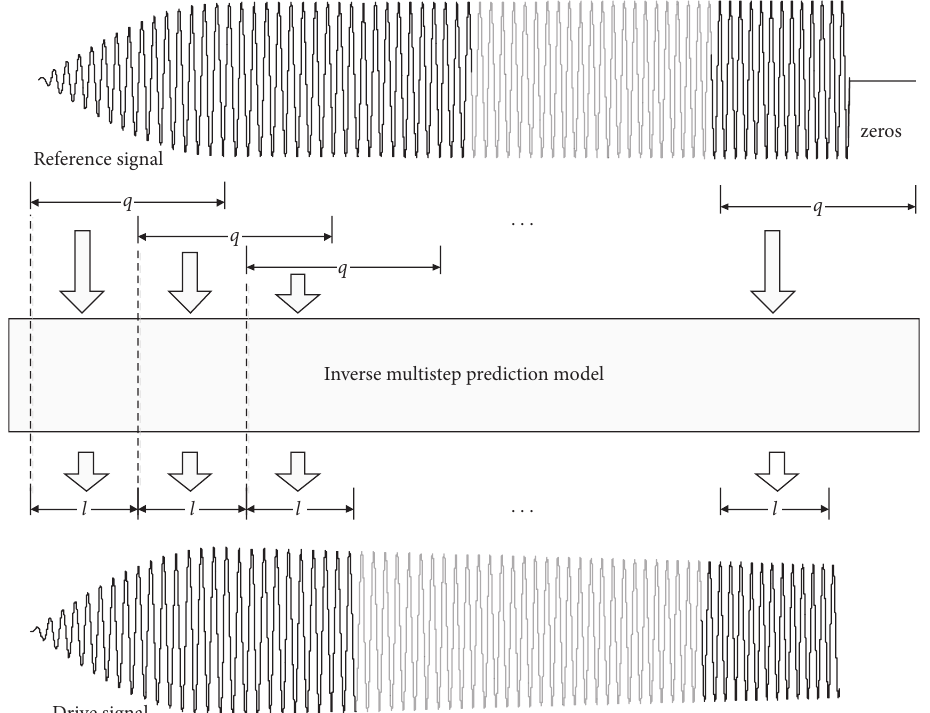
Figure 2: Drive signal is generated by the inverse system method and the reference signal is used in an overlapped